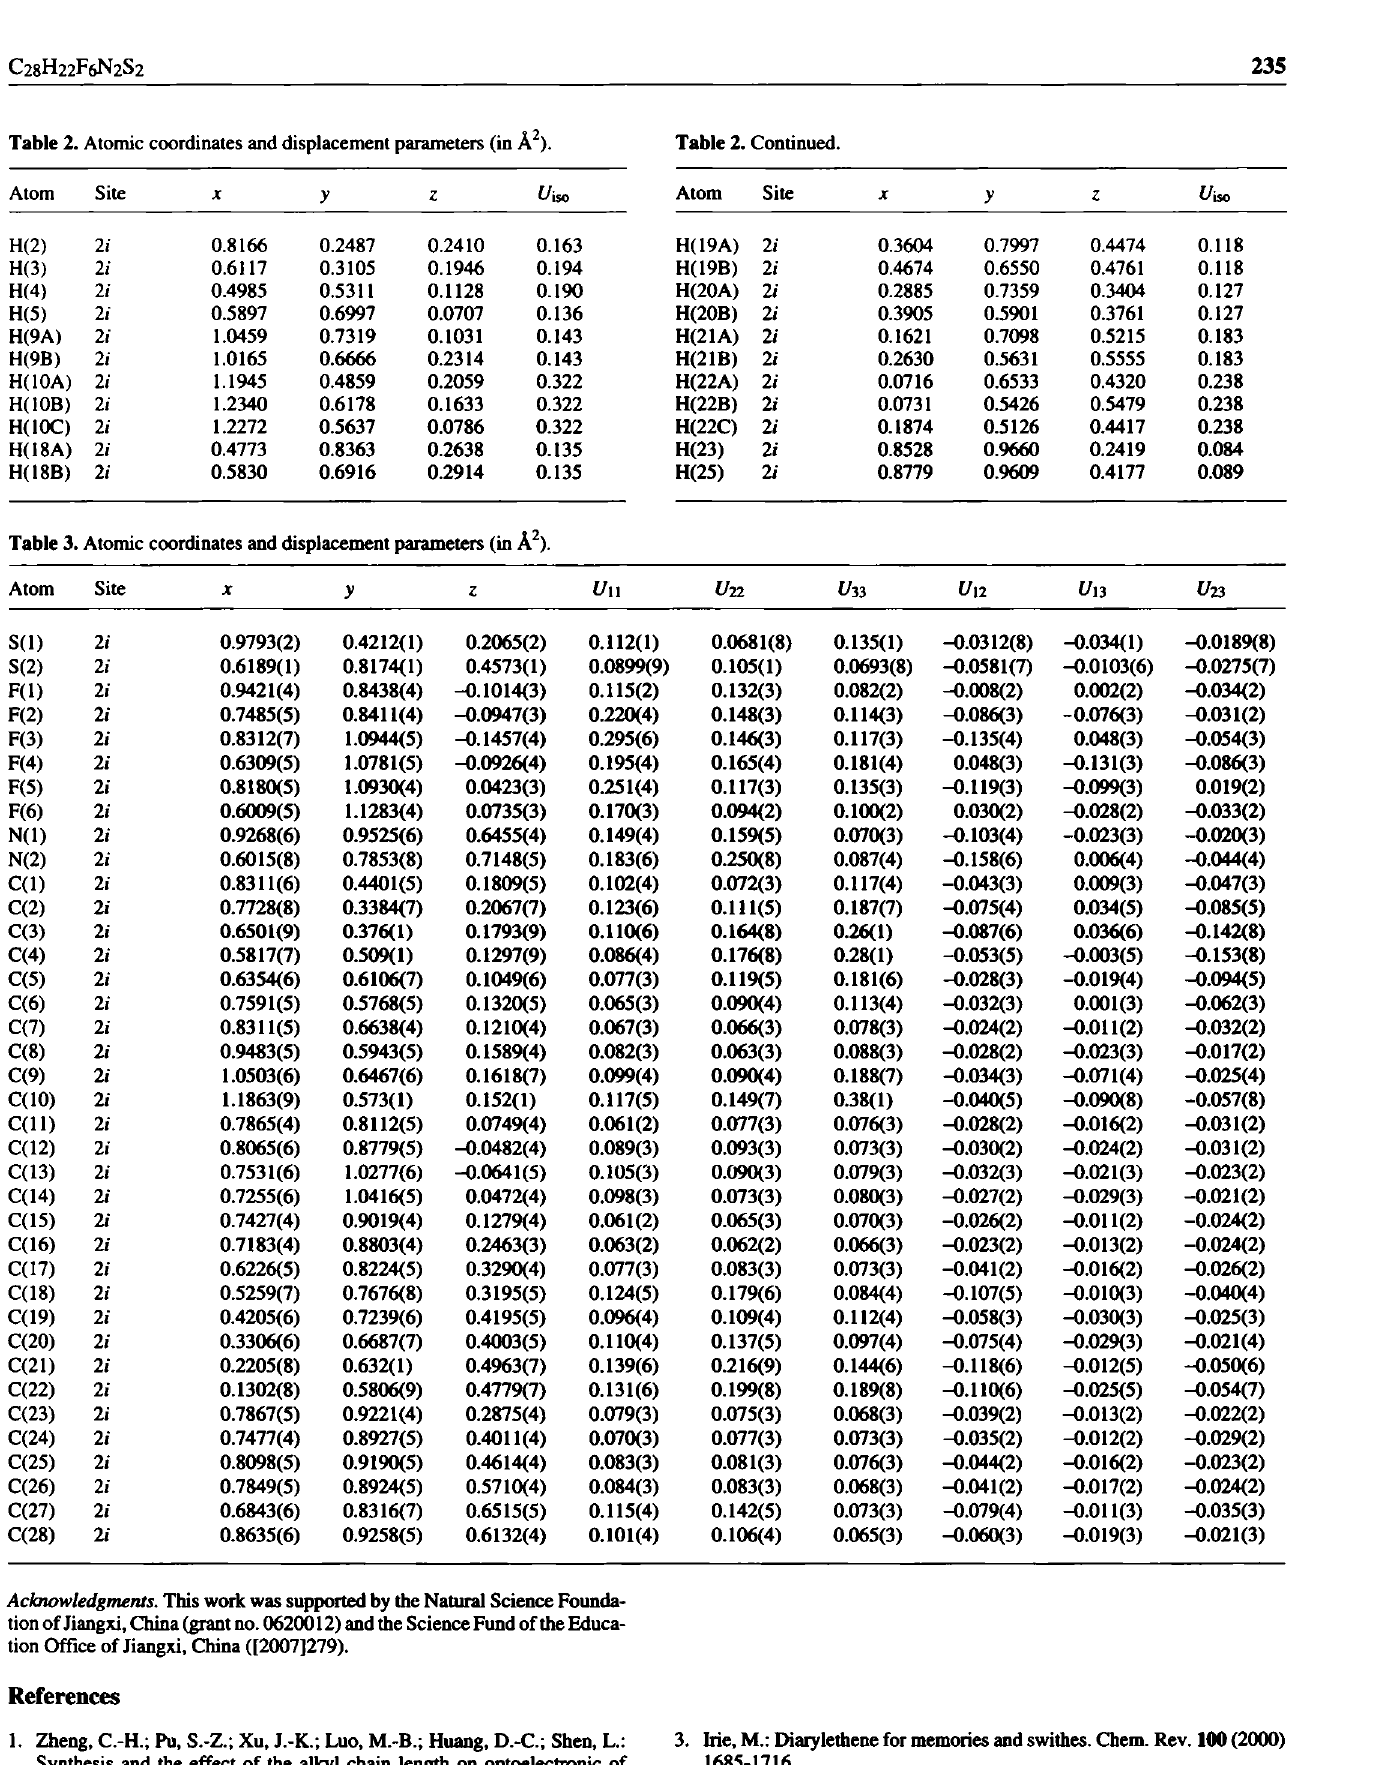
Table 2. Atomic coordinates and displacement parameters (in Â 2 ).